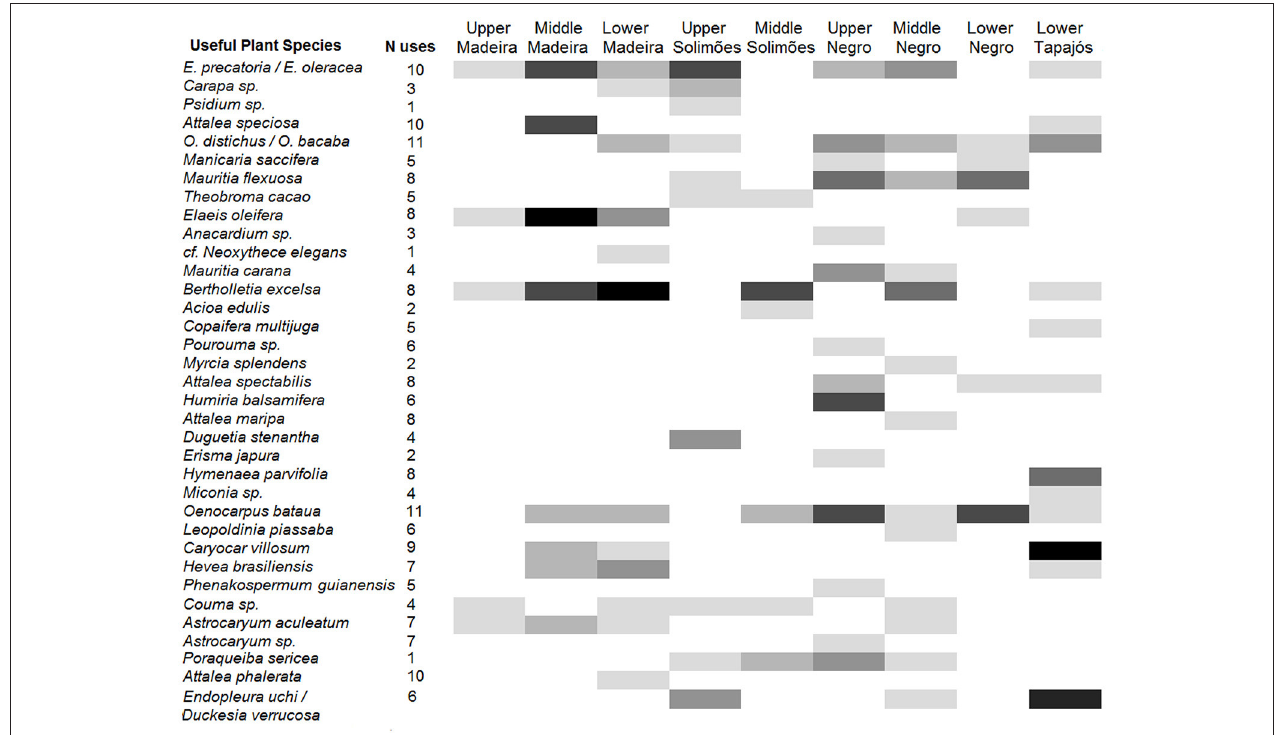
FIGURE 4 | Forest patches of useful species found in nine Amazonian sub-basins. Shades of gray indicate the frequency of citation in each sub-basin (very light gray–1 to black–7 citations). The total number of uses was obtained from both the literature review and field interviews. See Supplementary Table 1 for more information on the forest patches and uses attributed to each